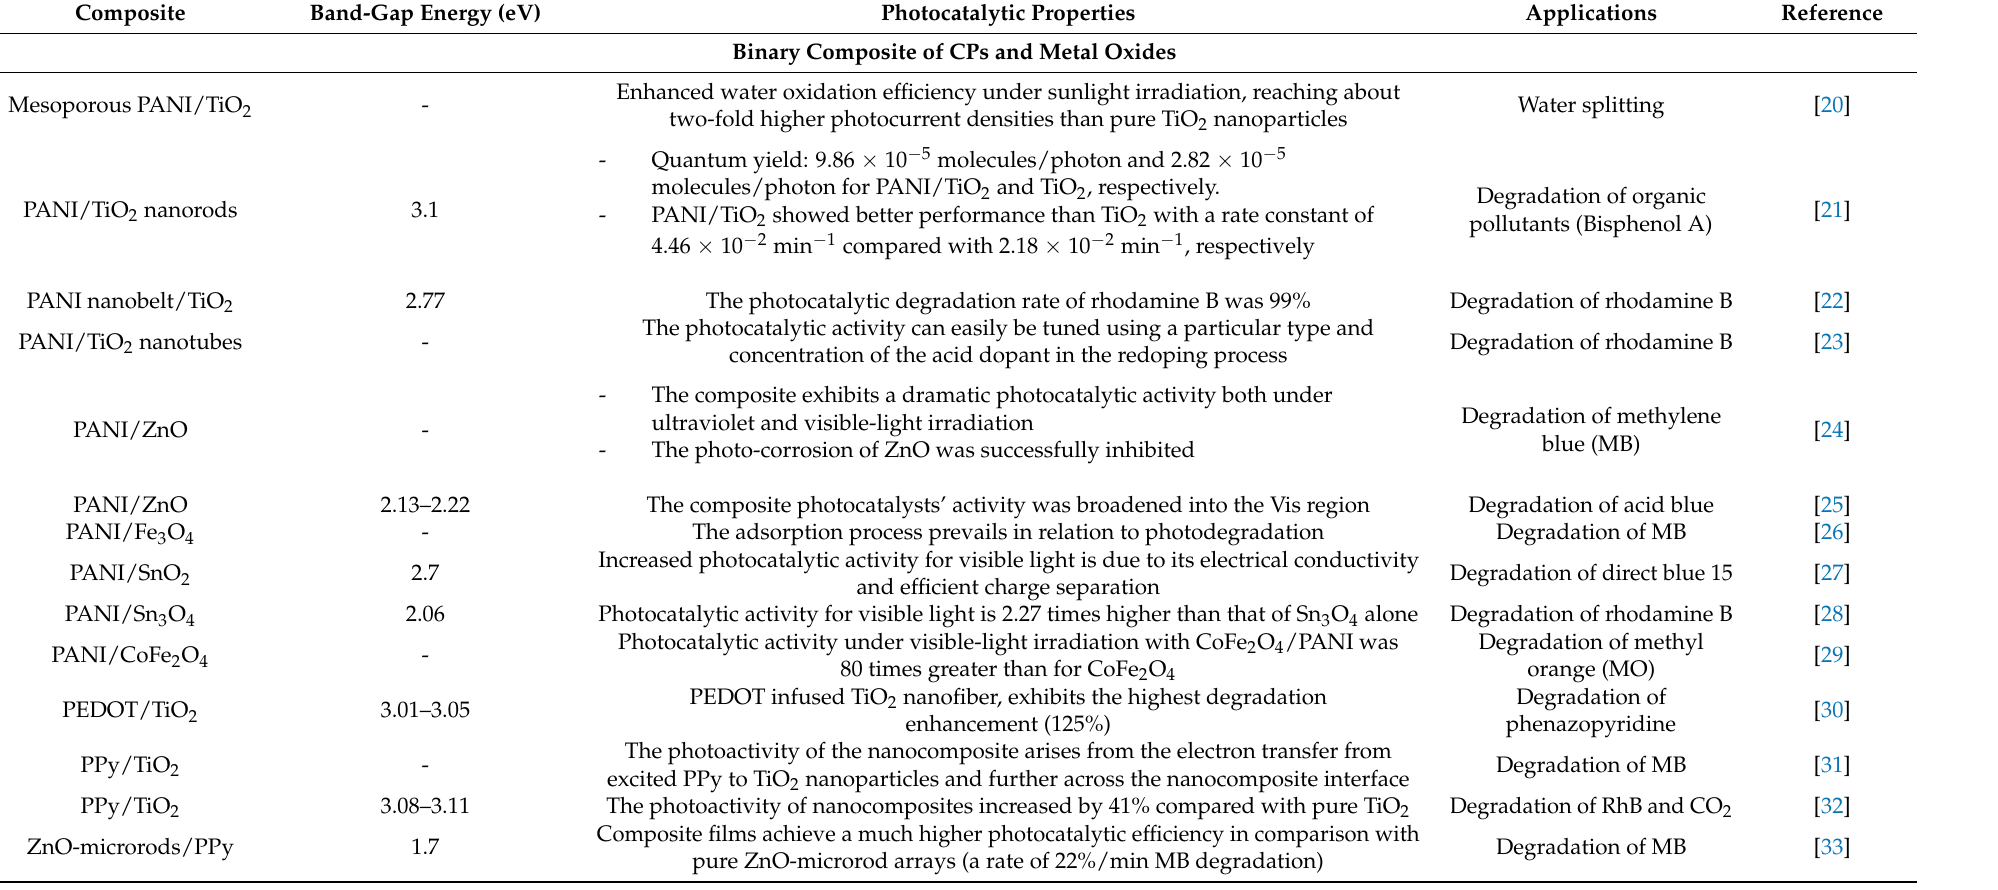
Table 1. Summarized properties and applications of conducting polymer/metal oxide composites as